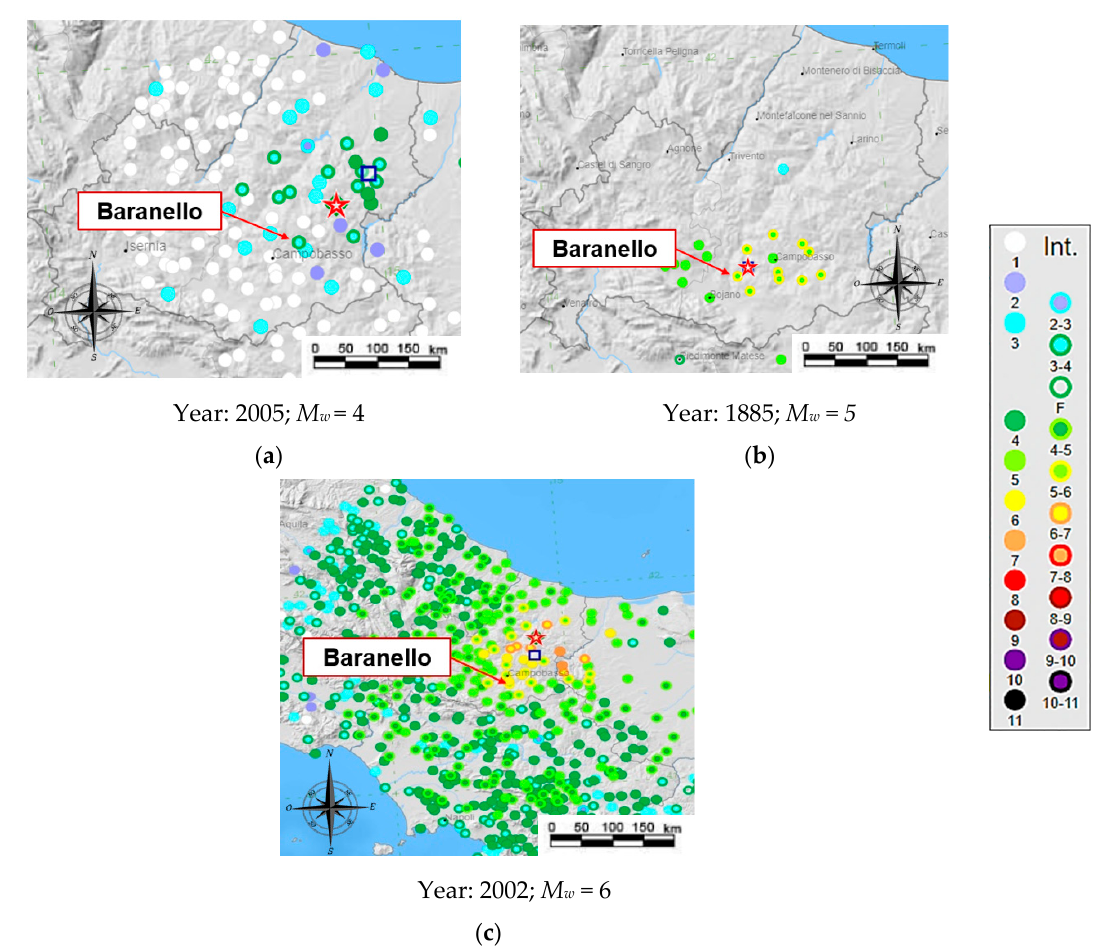
Figure 13. The earthquakes selected for the case study area [43].